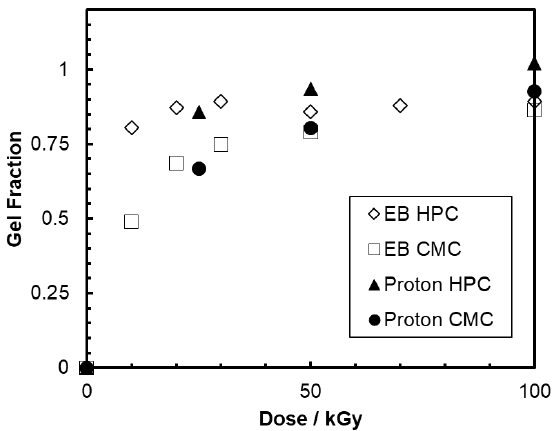
Figure 4. Gel fraction of hydroxypropyl cellulose (HPC) and sodium carboxymethyl cellulose (CMC) hydrogels obtained by 3.0 MeV proton beam or 2 MeV electron beam irradiation.